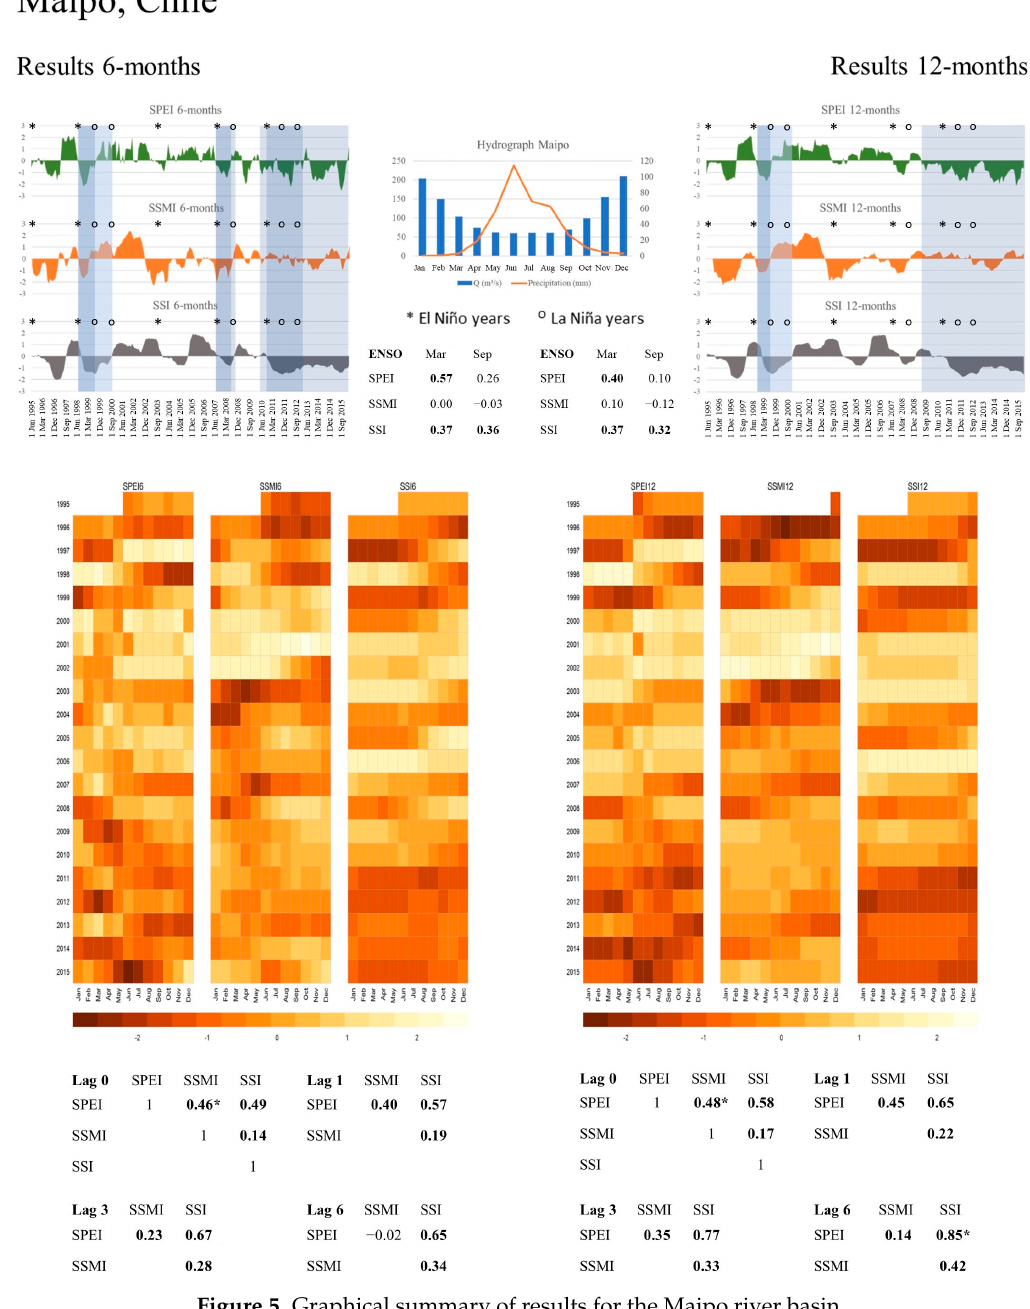
Figure 5. Graphical summary of results for the Maipo river basin. Table 2. Highest Pearson correlations between indices with lagged months (all statistical significant p ≤